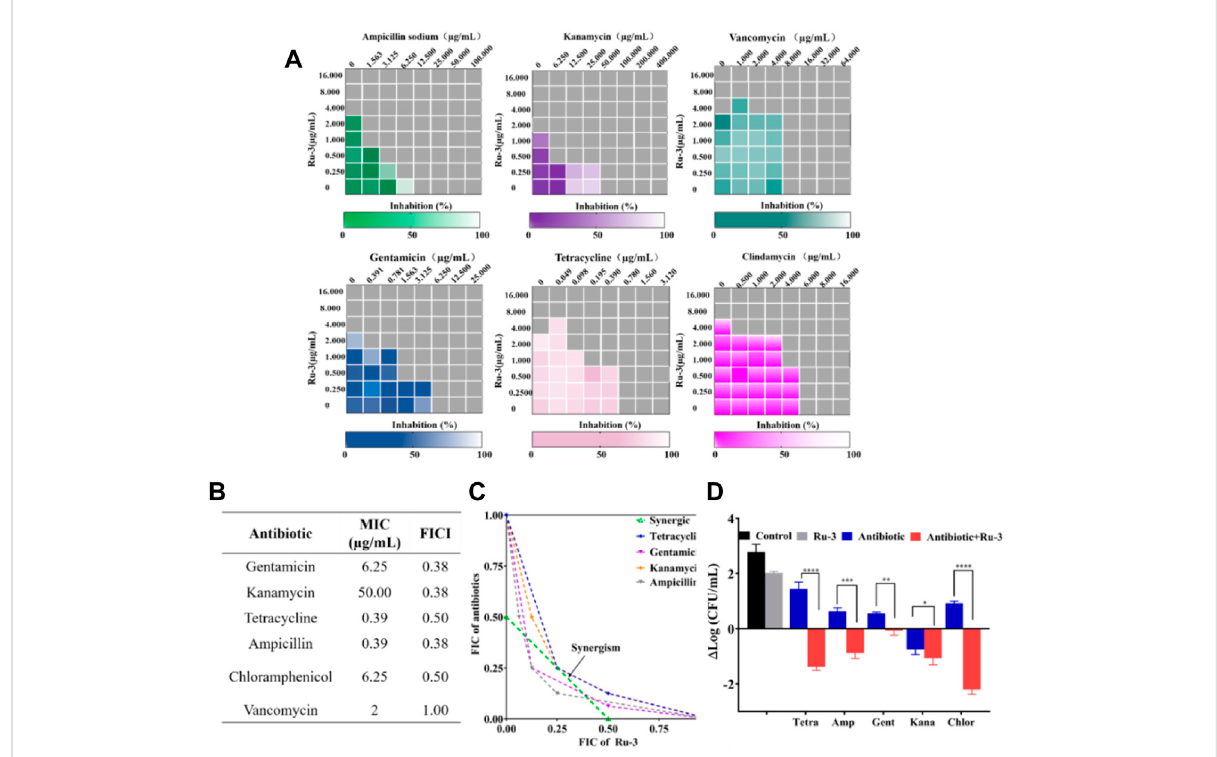
FIGURE 9 (A) Heat plots of checkerboard assays for Ru-3 in combination with different antibiotics against Staphylococcus aureus . (B) MIC of antibiotics and fractional inhibitory concentration indices (FIC) of the combination with Ru-3 against Staphylococcus aureus (C) An isobologram analysis of the synergistic effects of Ru-3 with Ampicillin, Chloramphenicol, Gentamicin, Kanamycin and Tetracyclines. (D) Logarithmic change of CFU mL − 1 (from time zero) of Staphylococcus aureus after treatment with Ru-3 (2 μ g ml − 1 ) and antibiotics with combined effect (0.25 MIC) for 3 h.